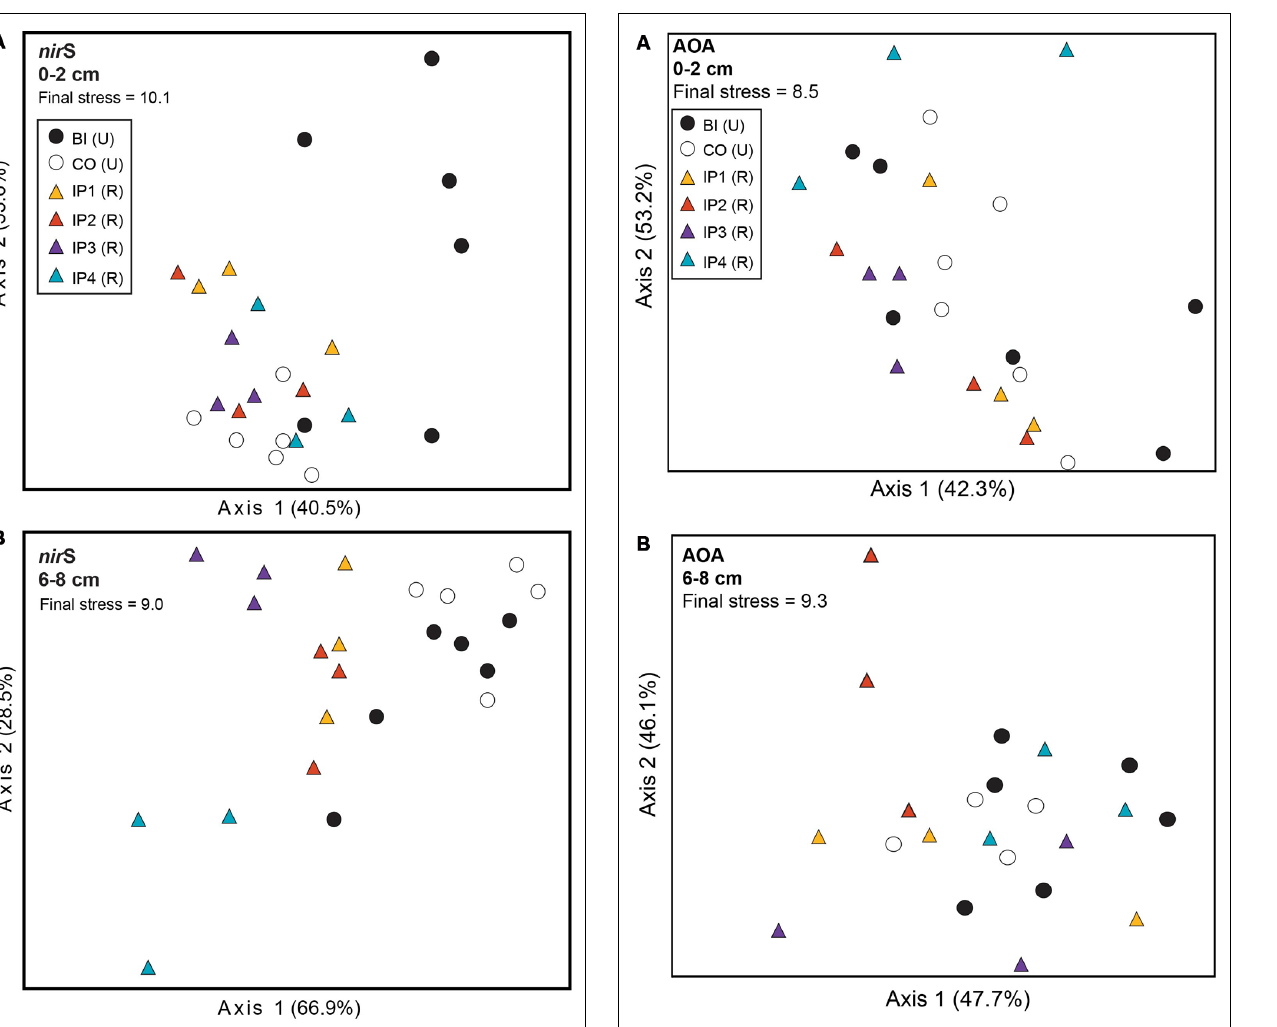
FIGURE 2 | Non-metric multidimensional scaling (NMS) plot ofTRFLP profiles for nir S genes in surface (A) and deep (B) sediments. Percent variability explained by each axis is shown parenthetically on the axis labels. In both panels, triangles represent restored (R) marshes (Impoundments 1–4); circles represent undisturbed (U) marshes from Barn Island (BI) or Cottrell (CO) marshes.